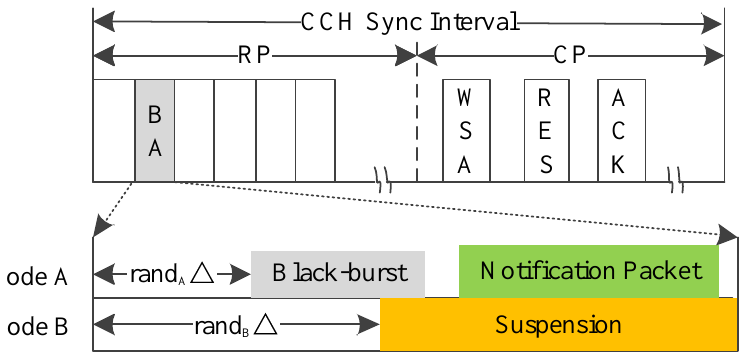
Figure 15. Time structure of BB-MAC.